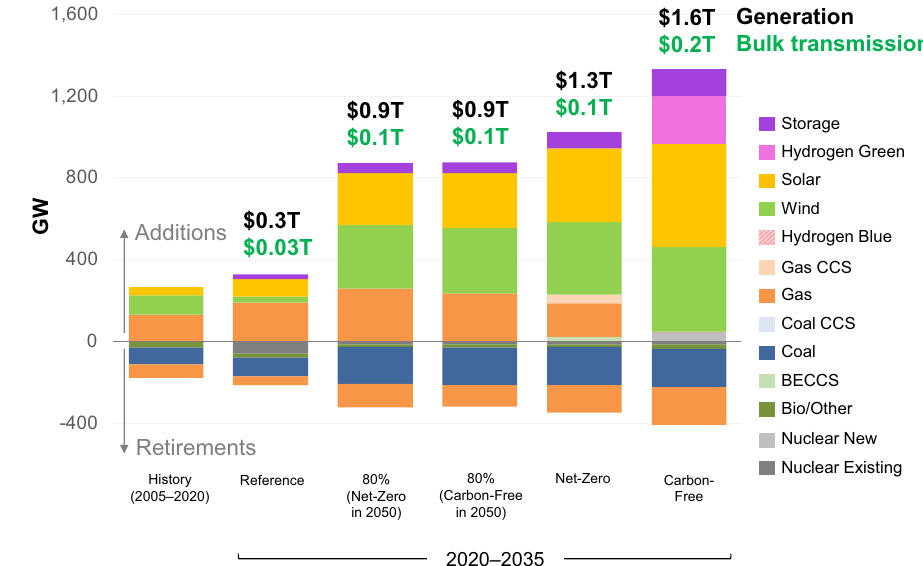
Fig. 2 | Capacity investments and retirements by technology and scenario through2035. HistoricaladditionsandretirementscomefromFormEIA-860data. Monetary investments in generation and bulk transmission are shown above each